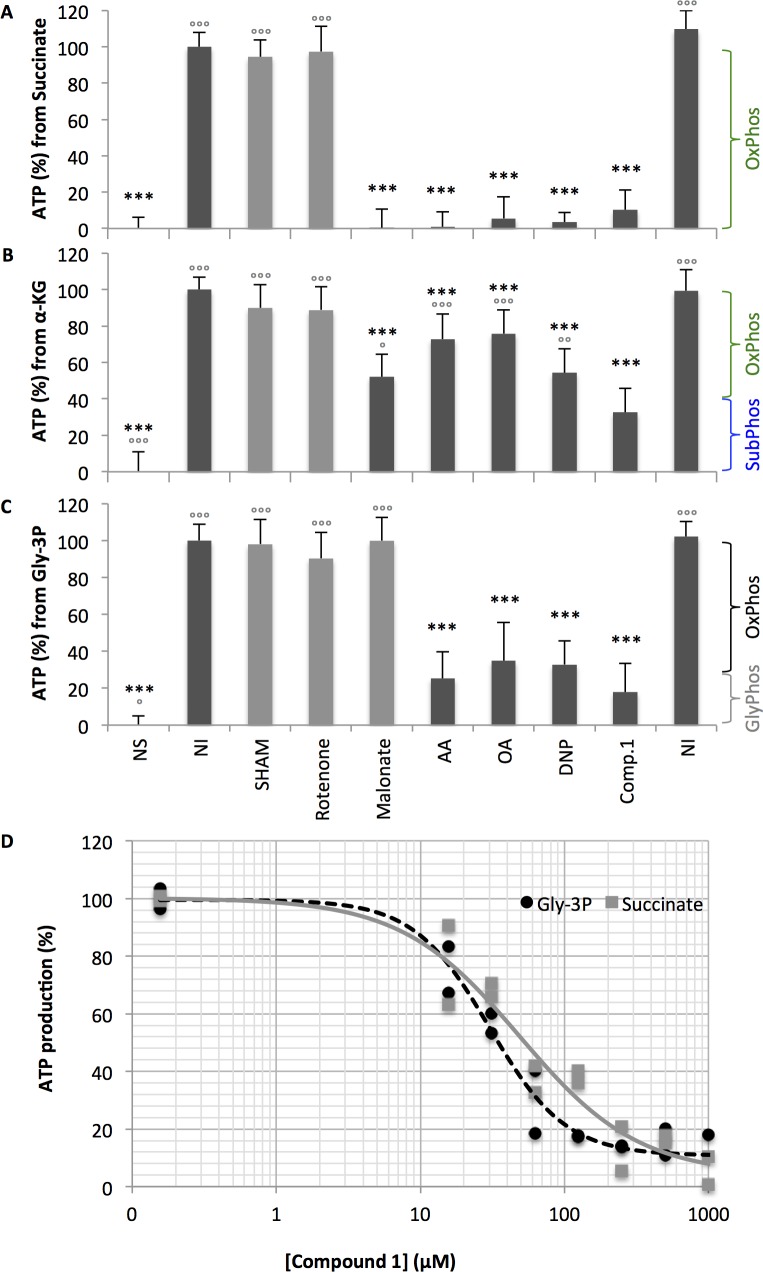
Inhibition of ATP production in digitonin-permeabilsed cells.(A-C) Digitonin-permeabilised PF T. brucei were probed with substrates in the presence of inhibitors and resulting ATP production quantified by bioluminescence assay. See experimental section for details. Inhibitors were used at saturating concentrations to ensure that relevant enzyme activities were ablated. Key: NS, no substrate; NI, no inhibitor; SHAM, salicylhydroxamic acid (TAO inhibitor at 100 μM); Rotenone (complex I inhibitor at 100 μM); Malonate (complex II inhibitor at 5 mM); AA, antimycin A (complex III inhibitor at 200 μM); OA, oligomycin A (complex V inhibitor at 200 μM); DNP, 2,4-dinitrophenol (protonophore at 1 mM); Comp.1, compound 1 at 200 μM. Background relative light units (RLU) were subtracted from measurements and % ATP production normalised to the no inhibitor control. Data were averaged from three independent experiments, each performed in quadruplicate. Error bars show standard deviations. T-tests were performed against no inhibitor controls (black asterisks) and compound 1 (grey open circles) and significance values presented: p < 0.00005 (*** / °°°), p < 0.0005 (** / °°), p < 0.005 (* / °). (A) Succinate was used as a substrate to generate ATP solely through oxidative phosphorylation (OxPhos). Oxidative phosphorylation inhibitors malonate, AA, OA and DNP virtually eliminated all ATP production. Compound 1 almost eliminated ATP production and was indistinguishable from inhibitors of oxidative phosphorylation, suggesting that it too inhibits oxidative phosphorylation. (B) α-ketoglutarate yields 40% ATP through substrate-level phosphorylation (SubPhos) and 60% through oxidative phosphorylation. Malonate, AA, OA and DNP inhibit oxidative phosphorylation, but not substrate-level phosphorylation. Compound 1 acted similarly, albeit with a minor additional effect (possibly on DLST, which was also a pull-down hit), suggesting oxidative phosphorylation is its major target. (C) Gly-3P acts as an alternative entry site to the electron transport chain yielding ATP through oxidative phosphorylation and the glycosome (GlyPhos). Malonate has no effect, as it acts at a different entry point. AA, OA and DNP inhibit oxidative phosphorylation, but not glycosomal phosphorylation. There is no significant difference between compound 1 and oxidative phosphorylation inhibitors, suggesting compound 1 acts downstream of complex II. (D) IC50 determination of compound 1 in digitonin-permeabilised cells when succinate (57.3 ± 14.5 μM) or Gly-3P (39.2 ± 4.6 μM) is used as substrate. The efficacy of compound 1 was similar for both substrates indicating that blockade is downstream of them both.